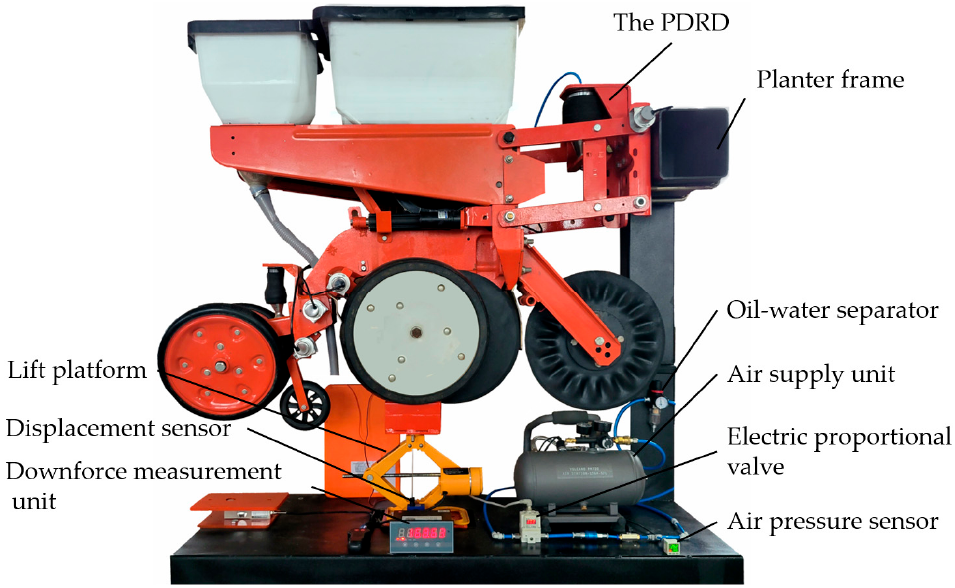
Figure 7. Seeding unit downforce test bench.